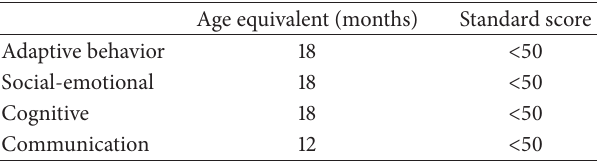
Table 2: Developmental profile: 3 at age 5.